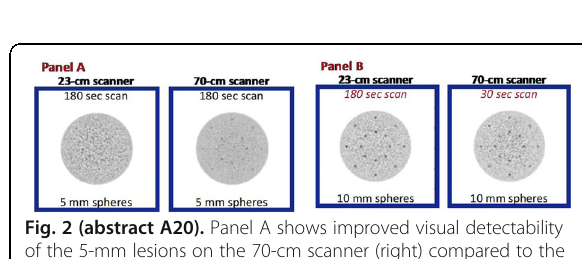
Fig. 2 (abstract A20). Panel A shows improved visual detectability of the 5-mm lesions on the 70-cm scanner (right) compared to the 23-cm scanner (left). Panel B shows similar visual detectability of the 10-mm lesions between a 3-min scan on the 23-cm scanner (left) and a 30-s scan on the 70-cm scanner (right). Because of the sensitivity gain with the longer AFOV, a 30-s scan on the 70-cm scanner has roughly the same number of events as a 180-s scan on the 23-cm system. All images are shown for the same iteration